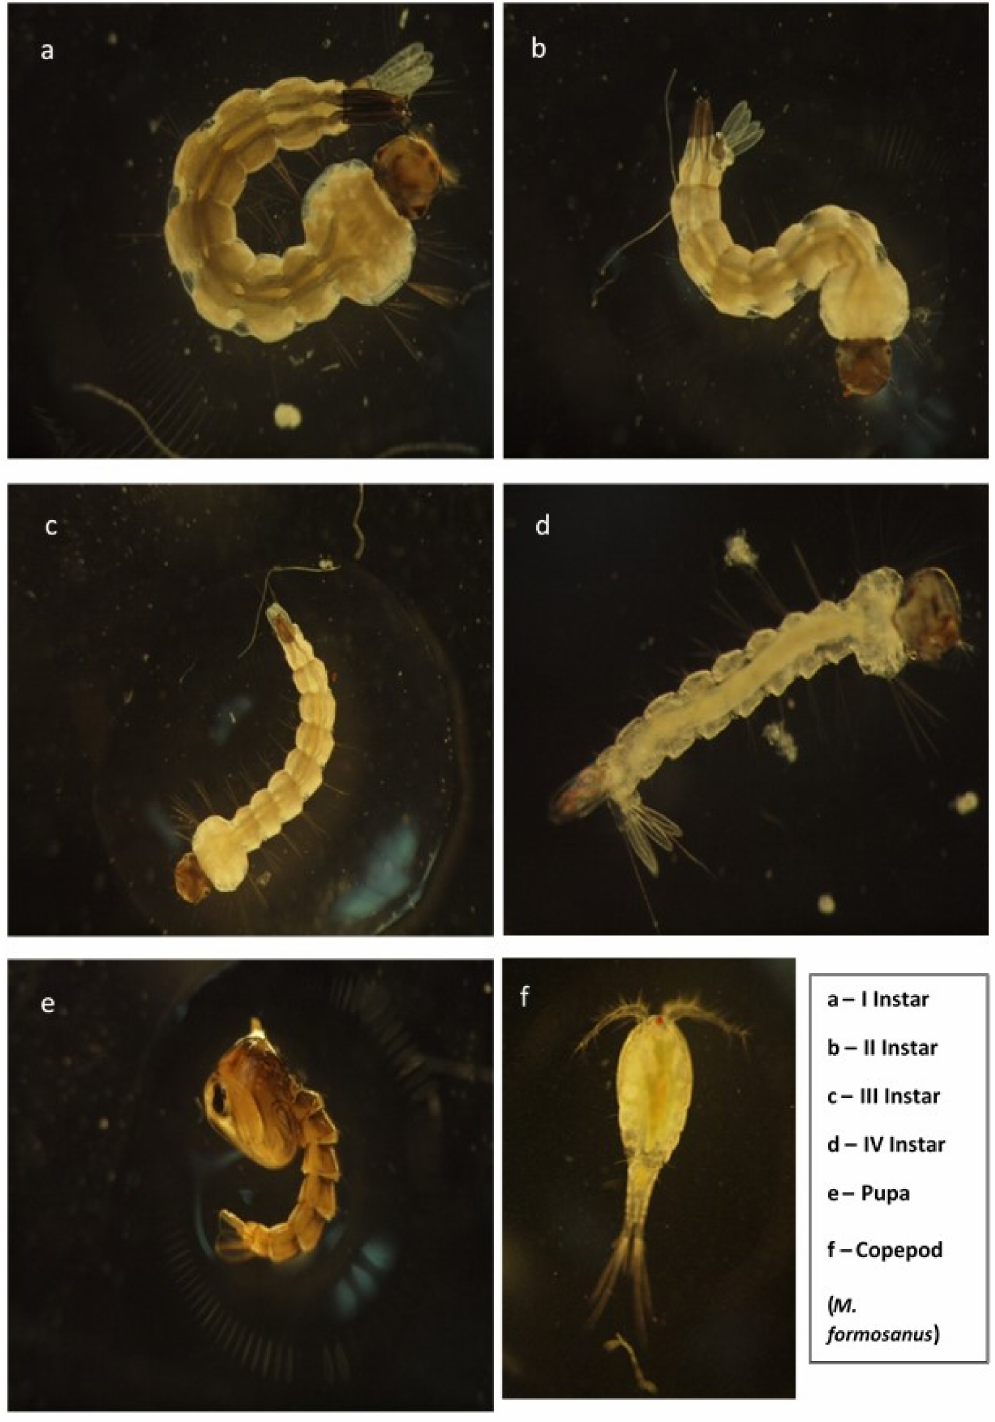
Figure 3. Young instars of Aedes aegypti before Larvasonic treatment: ( a ) I instar, ( b ) II instar II, ( c ) III instar, ( d ) IV instar, ( e ) pupae; and ( f ) non-target cyclopoid copepod Megacyclops formosanus